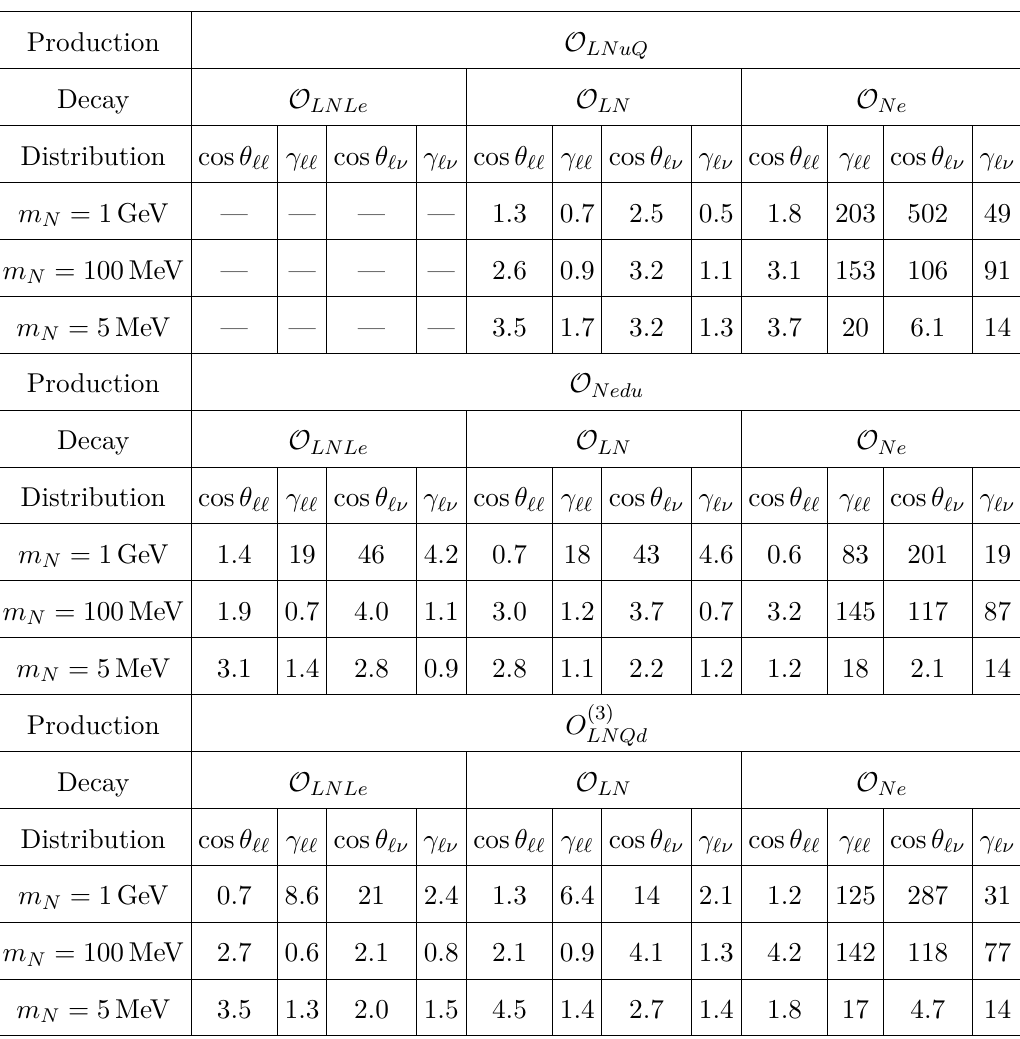
Table 12 . Same as table 11, except for three-body B